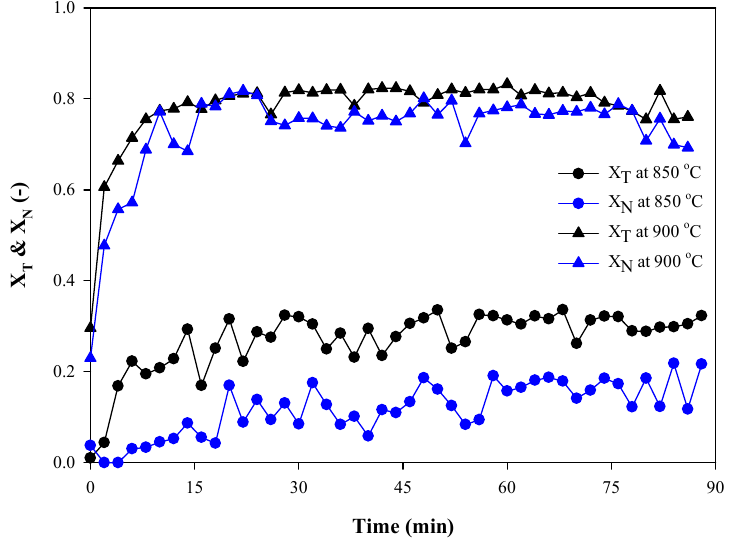
Figure 2. Conversions during 90 min tar reforming over PSC.